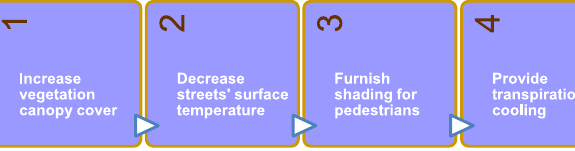
Fig. 1. Sub-assumptions of the study.